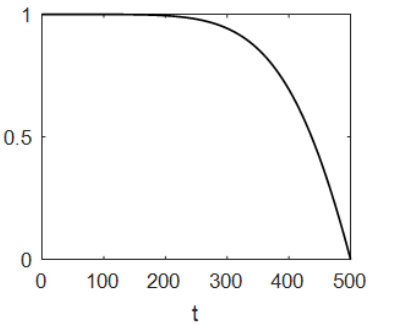
Figure 4. Graph of wandering step length change control.